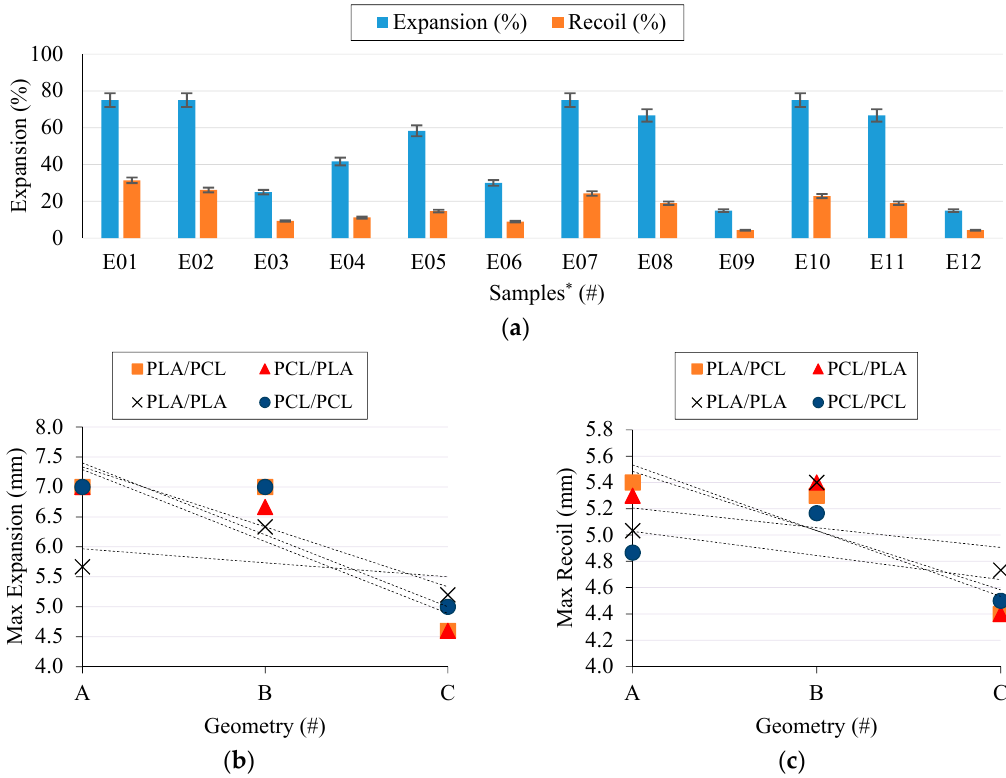
Figure 9. Radial expansion behavior results: ( a ) Expansion and recoil of each sample, ( b ) Main effect plot of geometry and layer order on radial expansion, ( c ) Main effect plot of geometry and layer order on radial recoil. * Samples numbered according to Table 3. PCL/PLA composite stent fabrication parameters.